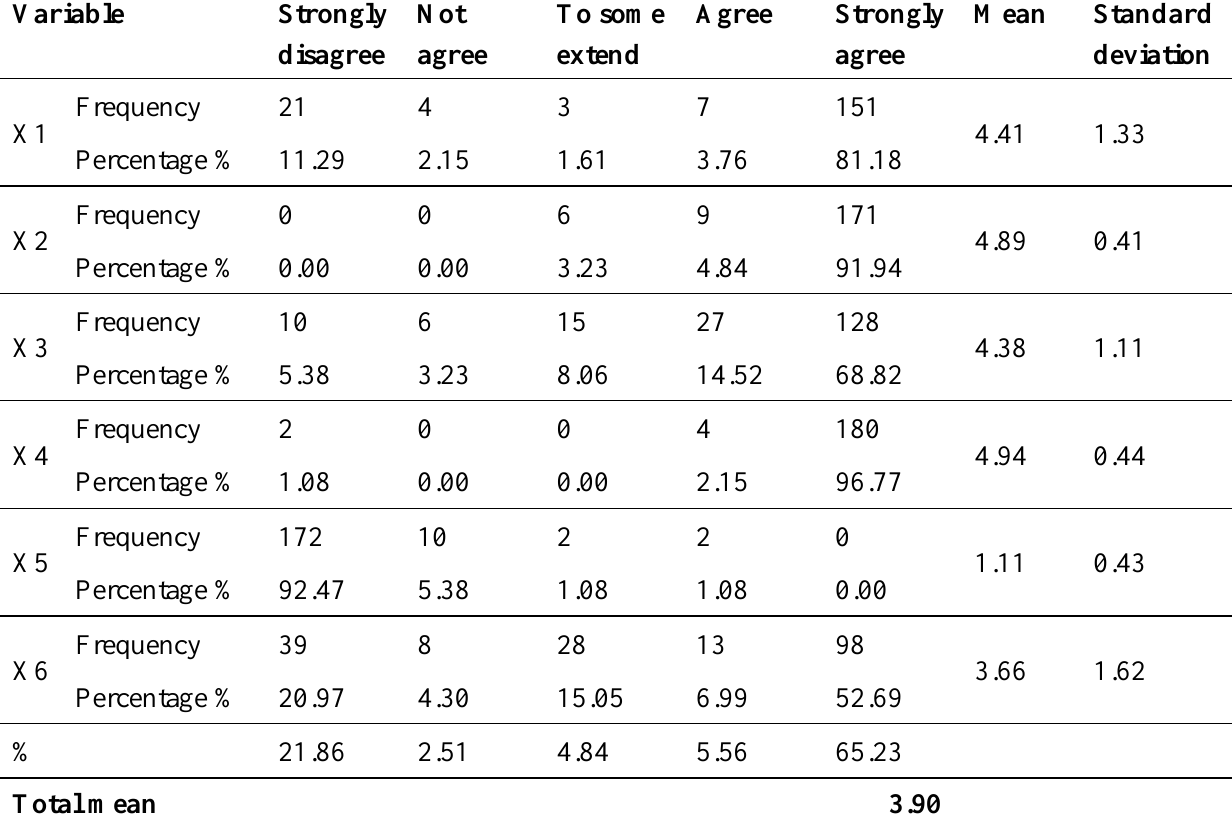
Table 4. Descriptive statistics for the axis (internal